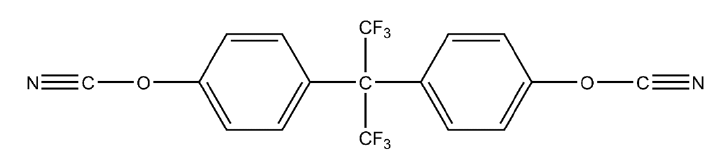
Figure 4. Molecular structure of tetrafunctional epoxy.